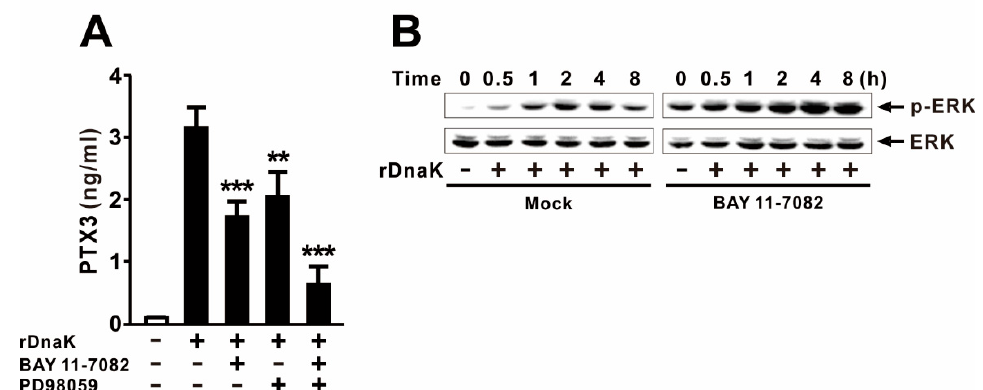
Figure 3. ERK engages in negative crosstalk with the NF- κ B signaling pathway. The dTHP-1 cells were pretreated for 1 h with 10 μ M of either BAY 11-7082 or PD98059 and then with 1 μ g/mL rDnaK for either 24 h ( A ) or the indicated times ( B ). After treatment, ELISA and immunoblot analyses were performed. Data in ( A ) are expressed as means ± SD ( n = 3). Data in ( B ) are representative of three separate experiments. ** p < 0.01; *** p < 0.001 vs. rDnaK treatment in the absence of inhibitors.